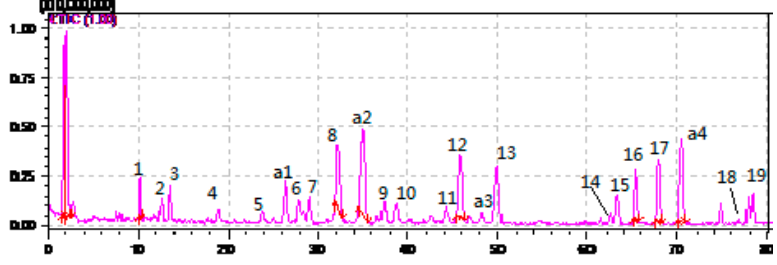
Figure 4. Negative mode of the HPLC-MS n chromatograms of P. cocos .